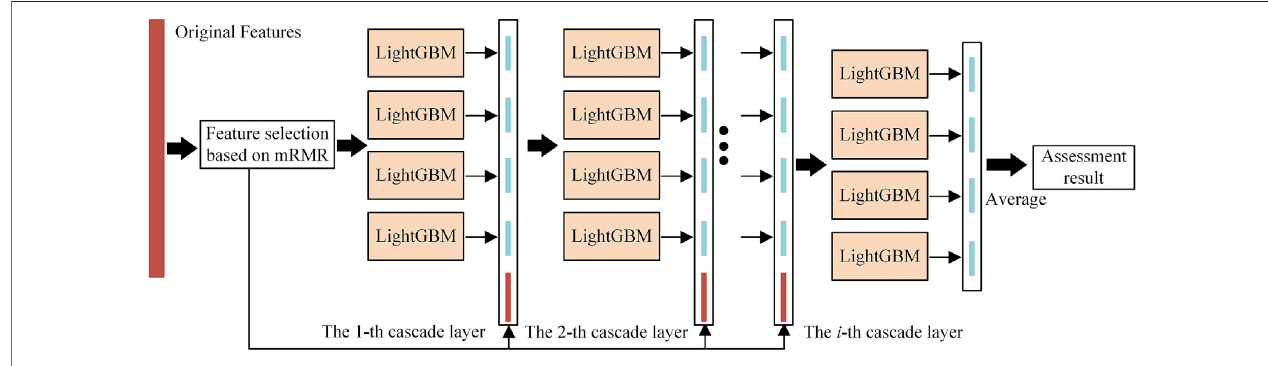
FIGURE 3 | The structure of